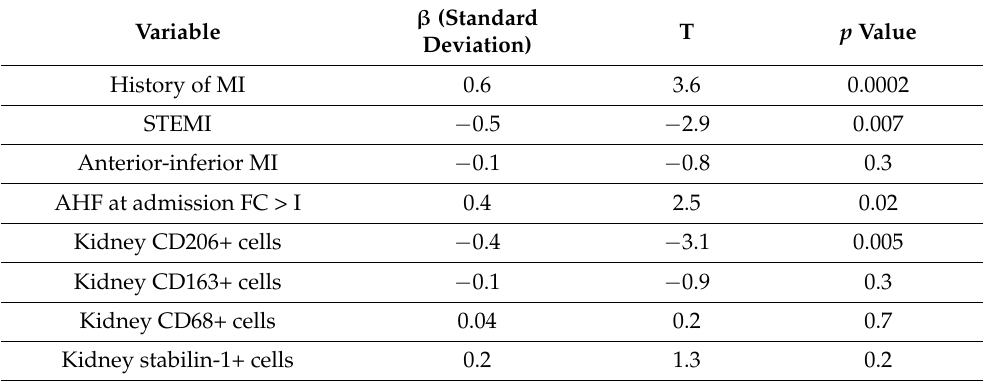
Table 4. Summary of multiple linear regression of clinical data and the number of CD206+, CD68+, CD163+, and stabilin-1+ cells in the kidney and early fatal outcome in patients with fatal MI ( n =